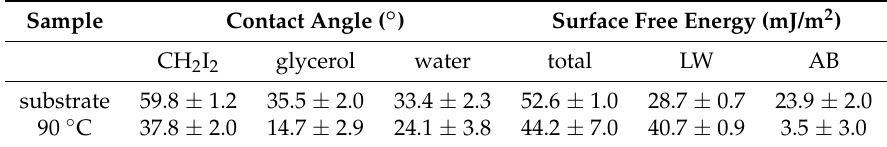
Table 3. The contact angles for different liquids and surface free energy and its components of bare substrate and POx films deposited at at substrate temperature of 90 ◦ C and at flow rate of 100 sccm.